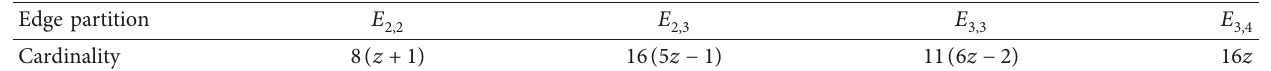
Table 6: The partition of the edge set of ( TM − TCNB ) 2 .